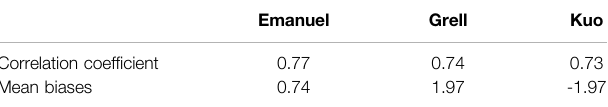
TABLE 1 | Correlation coef fi cients between observated and simulated Yangtze Meiyu by various CPSs and the 55-year mean biases of the simulation (unit: